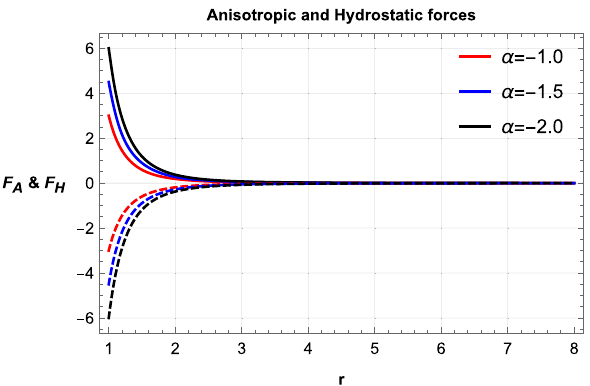
Fig. 20 Hydrostatic (plane lines) and anisotropic (dashed lines) forces for two sphere (case-2) with r 0 = 1 and D =